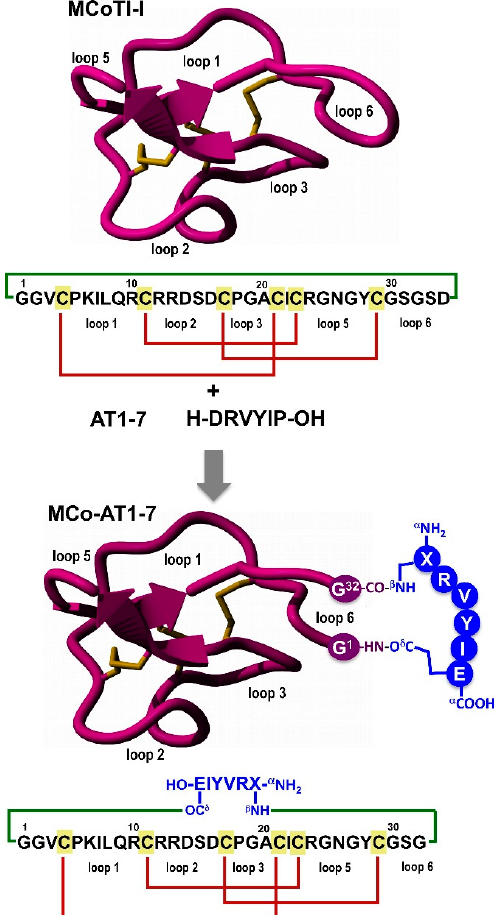
Figure 1. Design of grafted cyclotide MCo-AT1-7 to activate the receptor MAS1. The upper part of the panel shows the primary and tertiary structures of the cyclotide MCoTI-I (structure is based on a homology model using the solution structure of MCoTI-II as template (PDB: 1IB9) [14]), and the primary structure of peptide angiotensin 1-7 (AT1-7). The cyclized polypeptide is stabilized by the three-disulfide bonds (shown in red). The lower part of the figure shows the strategy used to graft an AT1-7-derived peptide onto the loop 6 of cyclotide MCoTI-I. The AT1-7-derived peptide was linked to the cyclotide backbone through the side-side chains of the N - and C -terminal residues forming two isopeptide bonds. The sequence corresponding to the AT1-7-derived peptides is shown in blue. Residue X represents L -2,3-diaminopropionic acid. Molecular graphics were built with Yasara (www.yasara.org). Naturally-occurring cyclotides have shown to possess various pharmacologically-relevant activities [7,15], and have been reported to be able to cross mammalian cell membranes [16,17] to antagonize intracellular protein-protein interactions in animal models [18]. The main features of cyclotides are a remarkable stability due to the CCK framework, a small size making them readily accessible to chemical synthesis, and an excellent tolerance to sequence variations. Altogether, these features make the cyclotide scaffold an excellent molecular framework for the design of novel peptide-based therapeutics [8,19] making them ideal substrates for molecular grafting of biological peptide epitopes [18,20–22].